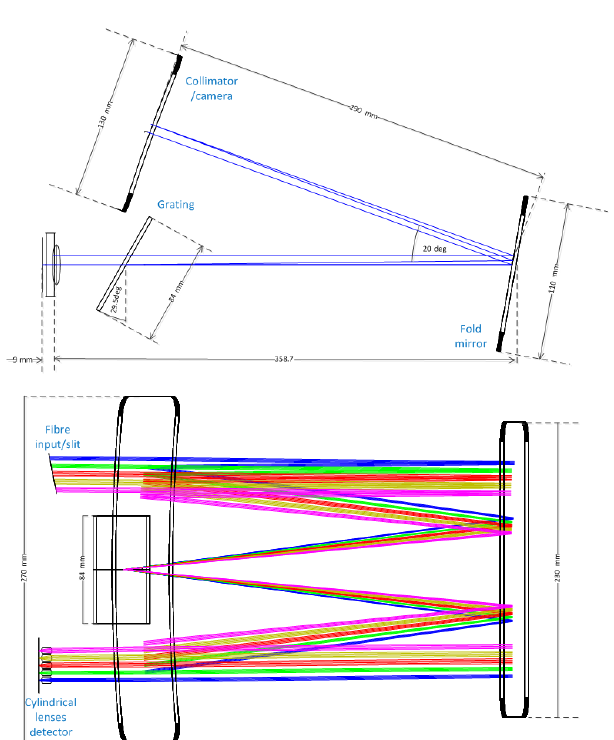
Figure 7. Elevation and plan view of the spectrometer showing the major dimensions, which allows it to fit into the cryostat optical module as shown in Fig. 5. The different coloured ray traces in the plan view diagram correspond to light from each of the five optical fibre